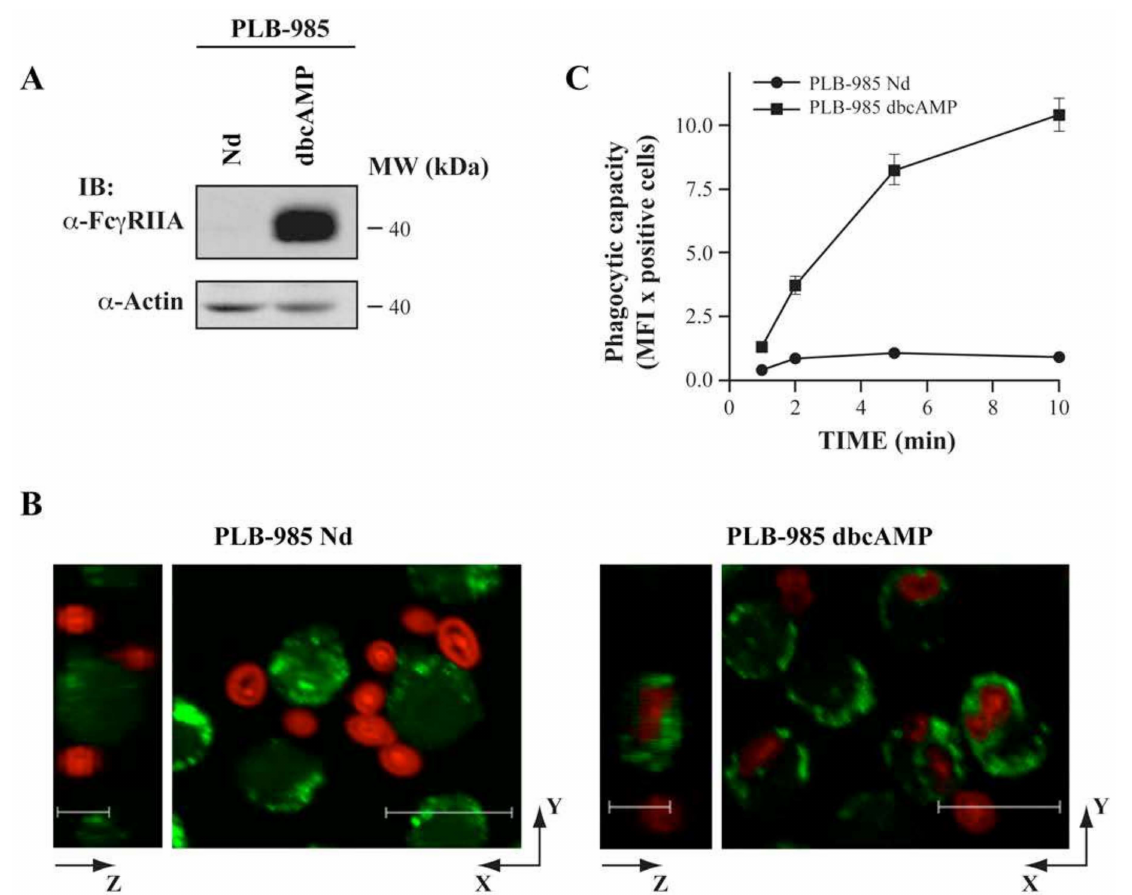
Figure 8. dbcAMP PLB-985 cells as a phagocytic model. ( A ) Protein samples (30 µ g per lane) of undifferentiated (Nd) and dbcAMP-differentiated PLB-985 cells were resolved by SDS-PAGE (7.5–20% gradients gels). Fc γ RIIA and actin were detected by Western blotting using CT10 (1/5000) and anti- actin (1/1000) antibodies, respectively. ( B ) Confocal scanning laser microscopy of undifferentiated (Nd) and dbcAMP differentiated-PLB-985 cells phagocytosing Alexa 594-conjugated opsonized zymosan particles (red) in a ratio of 10 particles per cell. Cells labeled with Calcein-AM (green) were allowed to phagocytose particles for 35 min. Vertical sections (y versus z) are shown in the left panel, and horizontal sections (x versus y) in the right panel. Images are representative of three independent experiments. Bars, 12 and 6 µ m. ( C ) FACS analysis of phagocytic capacity of undifferentiated (Nd) and dbcAMP-differentiated PLB-985. Cells were incubated with Alexa 488-conjugated opsonised zymosan particles for the indicated times. Phagocytic capacity was determined by multiplying the number of phagocytosing cells by the Mean Fluorescence Intensity (MFI). Each value represents the mean value ± SEM of four experiments, each performed in